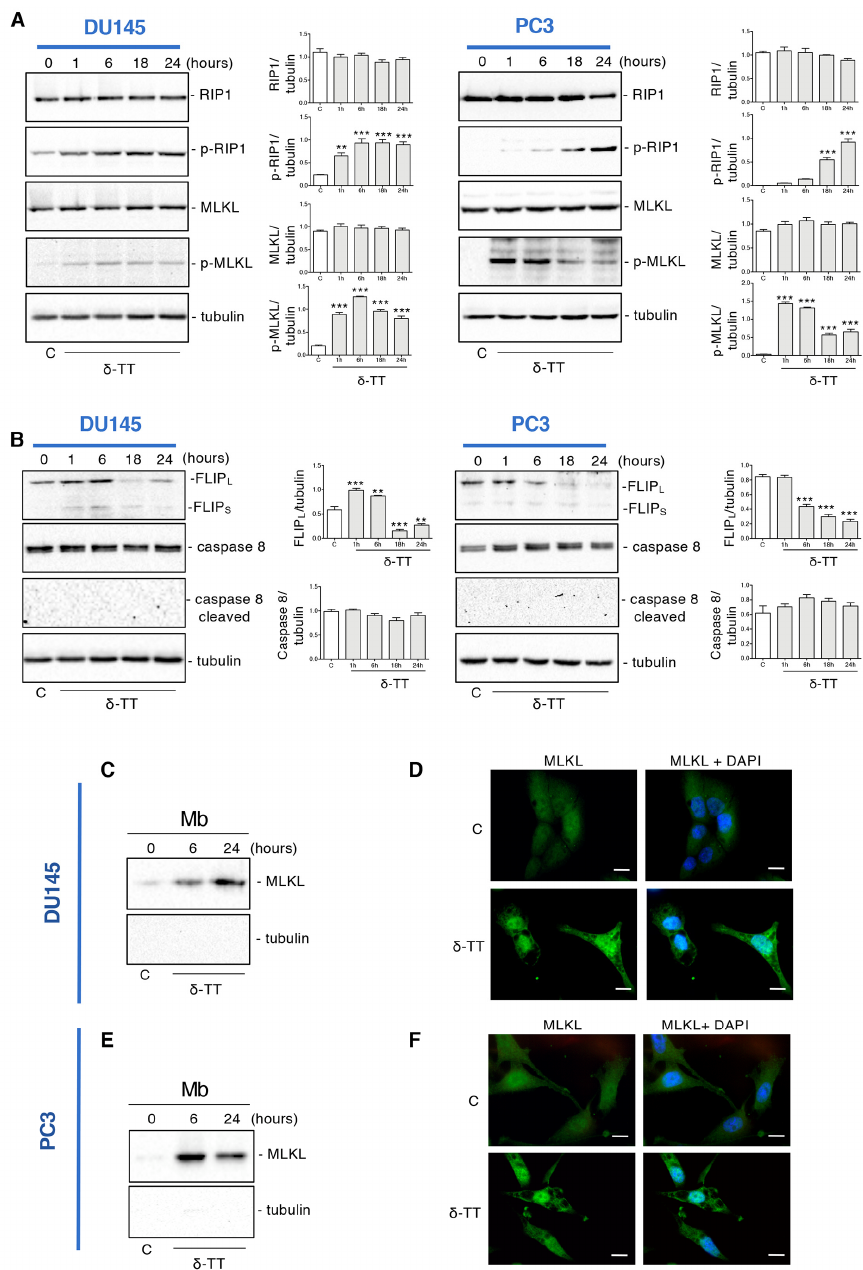
Figure 2. δ -TT induces necroptosis machinery in prostate cancer cells. ( A ) The expression of proteins involved in necroptosis activation (RIP1, p-RIP1, MLKL, p-MLKL) was analyzed by Western blot analysis after treatment with δ -TT (20 μ g/mL) from 1 h to 24 h in both DU145 and PC3 cells. Tubulin was used as loading control. Three independent experiment for each condition were analyzed; bar graph represents the mean optical density ± SD. Statistical analysis was performed using one-way ANOVA followed by Dunnett’s post-hoc test (** p < 0.01 vs. C; *** p < 0.001 vs. C). ( B ) The expression of FLIP L , FLIP S , caspase-8 and caspase-8 cleaved were analyzed by Western blot after treatment with δ -TT (20 μ g/mL) from 1 h to 24 h in both DU145 and PC3 cells. Tubulin was used as loading control. Three independent experiments for each condition were analyzed; bar graph represents the mean optical density ± SD. Statistical analysis was performed using one-way ANOVA followed by Dunnett’s post- hoc test (** p < 0.01 vs. C; *** p < 0.001 vs. C). ( C ) The expression of MLKL was evaluated in membrane preparations (Mb) after treatment with δ -TT (20 µ g/mL) for 6 h and 24 h in DU145 cells. Analysis of tubulin expression demonstrate the lack of cytosolic contamination in membrane preparations.